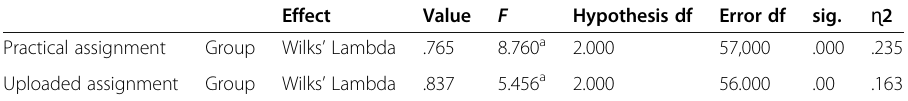
Table 9 Results of the MANOVA for cognitive engagement about assignment